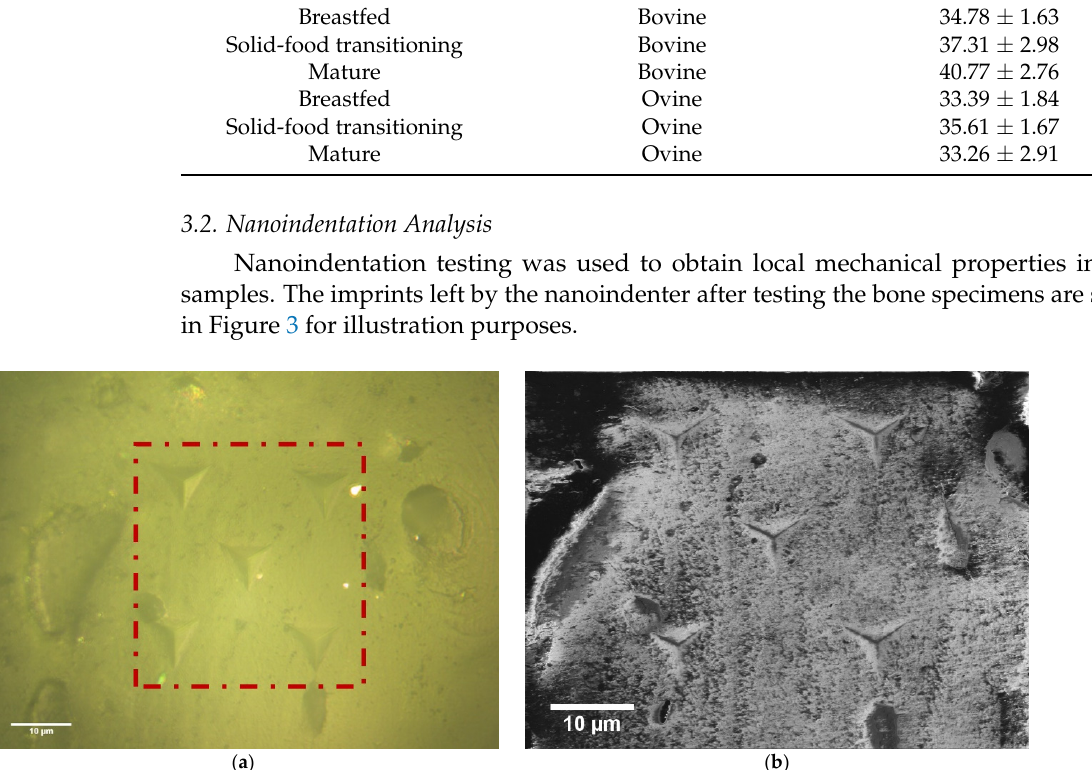
Table 2. Calcium mass percentages reported with EDX with their respective standard deviations.